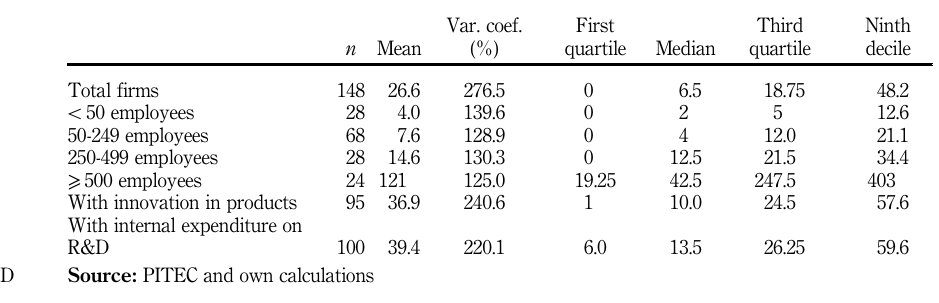
Source: PITEC and own calculations